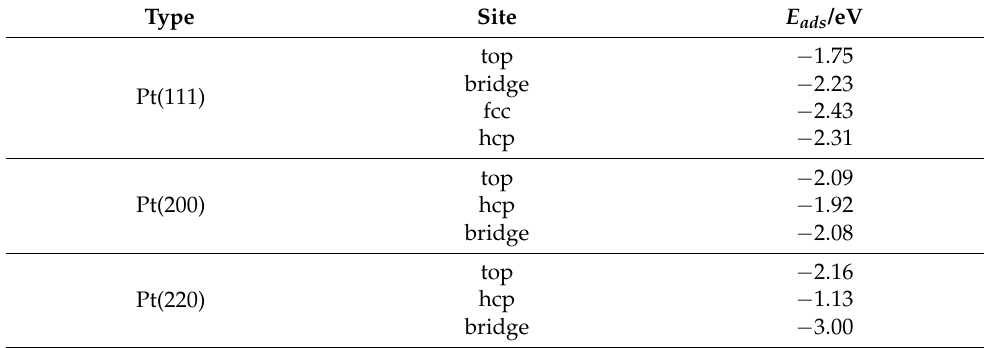
Table 1. Adsorption energies of NO on adsorption sites on Pt(111), Pt(200), and Pt(220) surfaces.